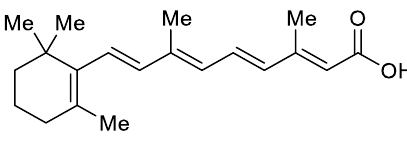
Figure 12. Structure of tretinoin.